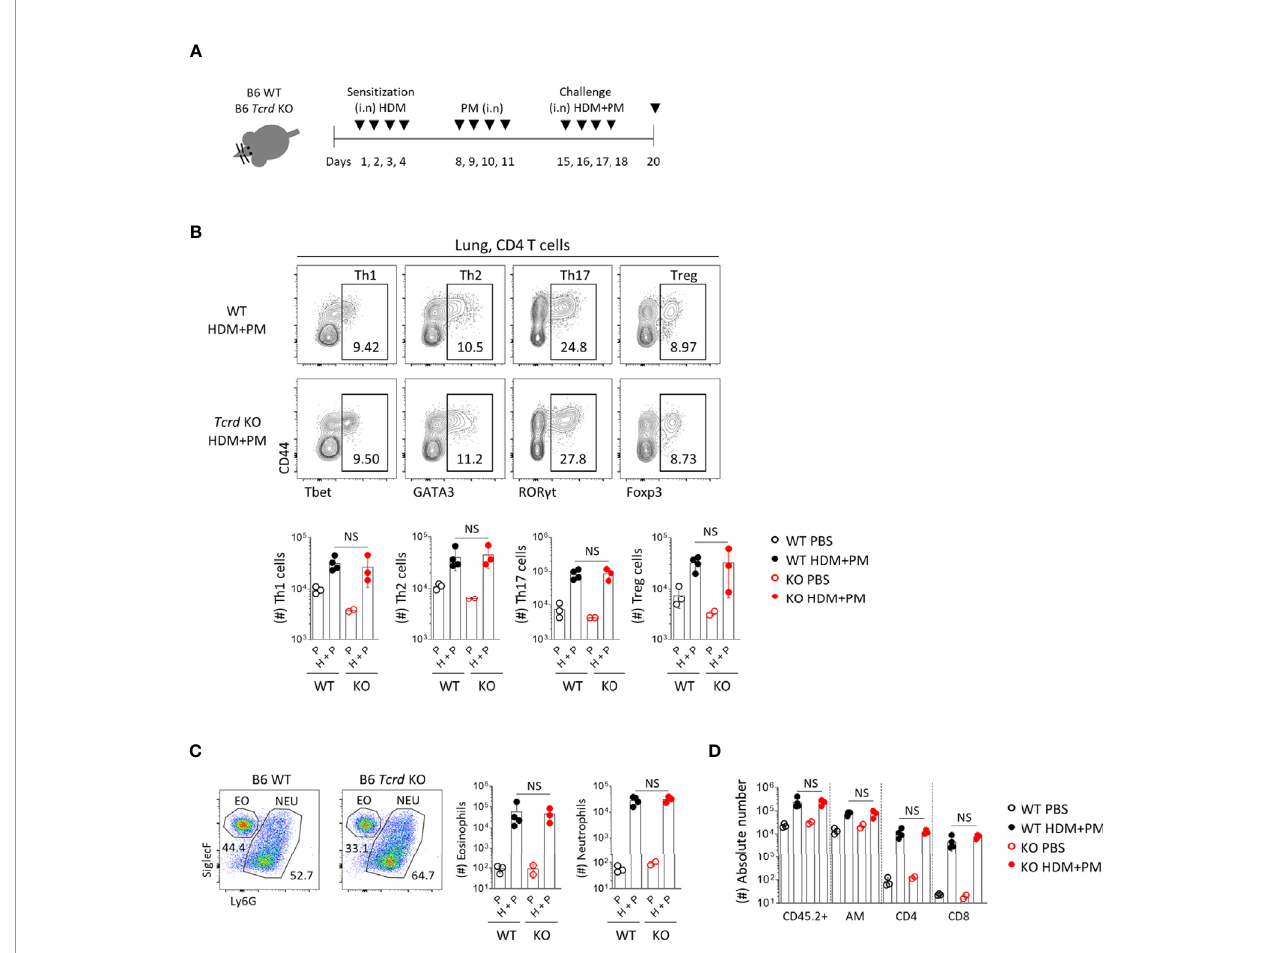
FIGURE 8 | T helper 17 cells function as the main effector cells in PM-induced chronic pulmonary in fl ammatory condition. B6 WT and Tcrd -/- mice were intranasally sensitized and challenged with 20 m g of HDM ( Dermatophagoides pteronyssinus ). Mice were administered with 250 m g of PM at day 8-11 and 15-18, and sacri fi ced at day 20. (A) Experimental scheme of HDM/PM-induced chronic allergic asthma is shown. (B) Representative contour plots show pulmonary CD4 + T cells. Bar graphs show statistical analysis of their absolute numbers. (C) Representative dot plots show eosinophils and neutrophils in BALF harvested at day 20. Bar graphs show statistical analysis of absolute numbers of eosinophils and neutrophils. (D) Bar graph shows statistical analysis of absolute numbers of total CD45.2 + , alveolar macrophages, CD4 and CD8 T cells in BALF at day 20. Numbers indicate frequencies of cells in adjacent gates. Each dot represents an individual mouse and error bars indicate ± SD. Unpaired two-tailed t -test was used. N.S, not signi fi cant ; EO, eosinophil; NEU, neutrophil; AM, alveolar